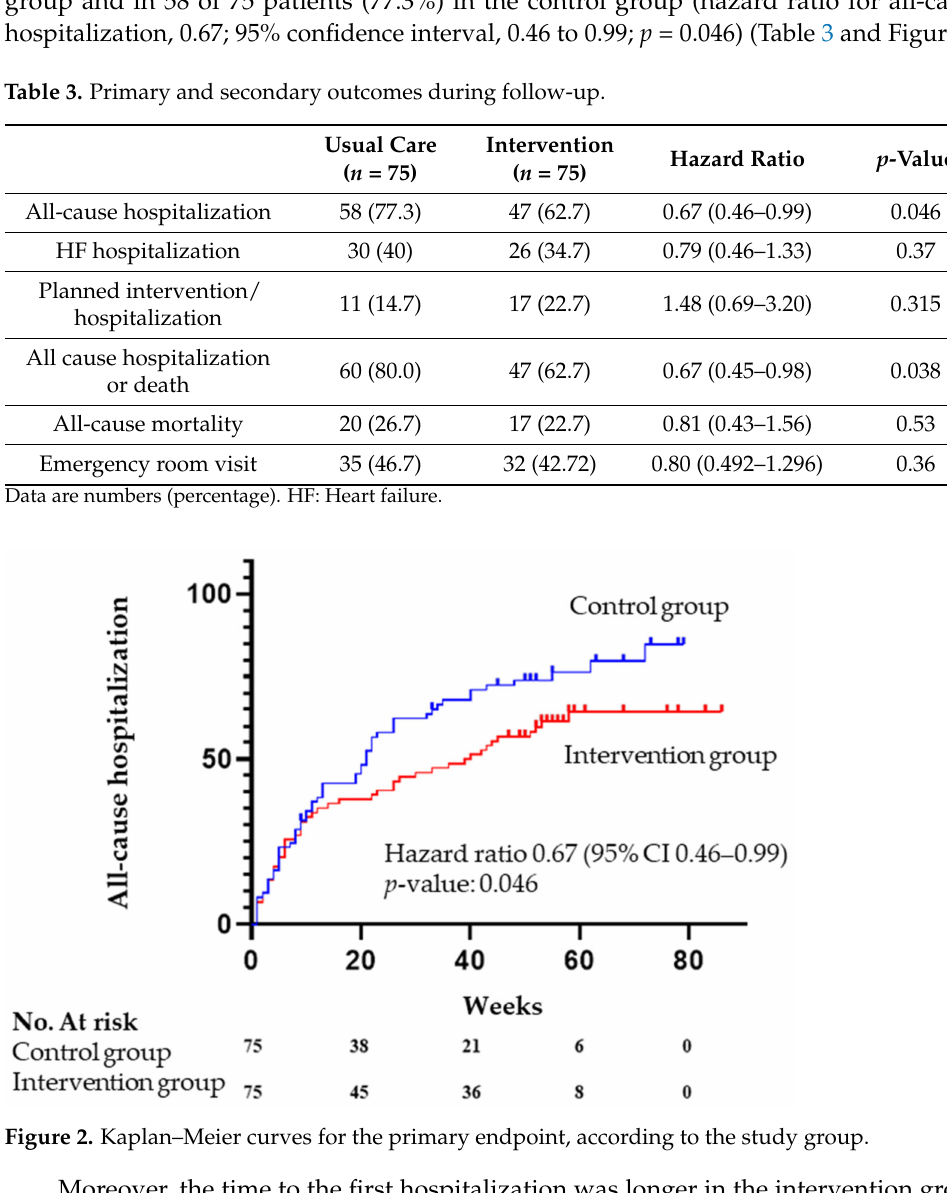
hospitalized (18 days (interquartile range: 4–28.5) in the intervention group and 16 (6–29) in the control group, p =